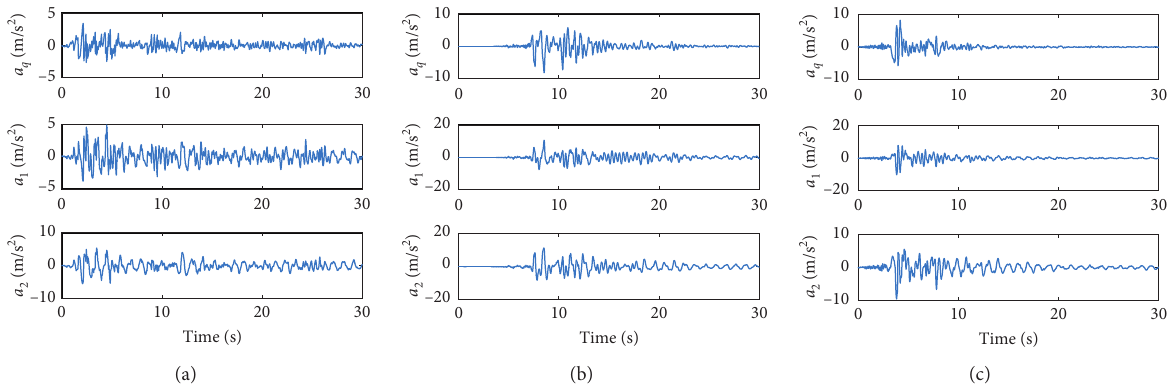
Figure 5: Acceleration responses of the simulated structure under different earthquake waves, ∗ a floor; a 2 is the acceleration responses of the second floor; a q is corresponding earthquake excitation. (a) El-Centro earthquake waves. (b) Kobe earthquake waves. (c) Northridge earthquake waves.